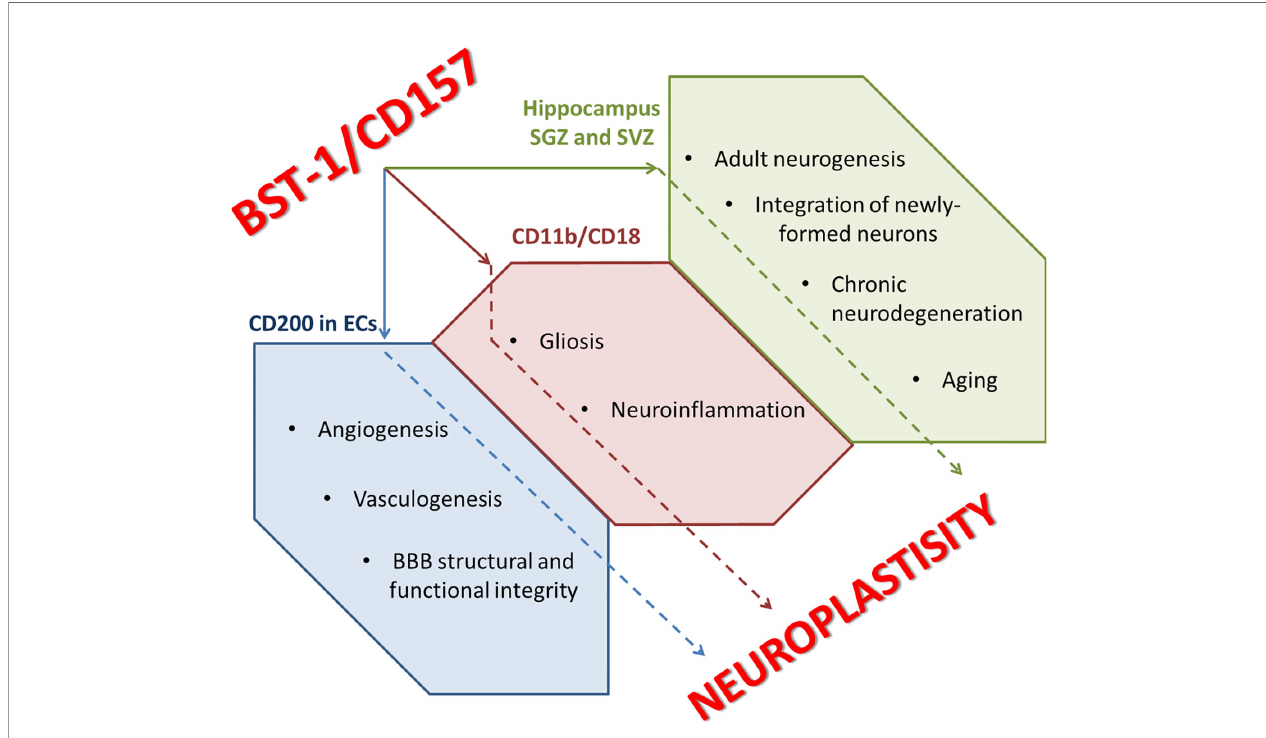
FIGURE 3 | CD157 and neuroplastisity. ECs, endothelial cells; SGZ, subgranular zone of hippocampus; SVZ, subventricular zone of